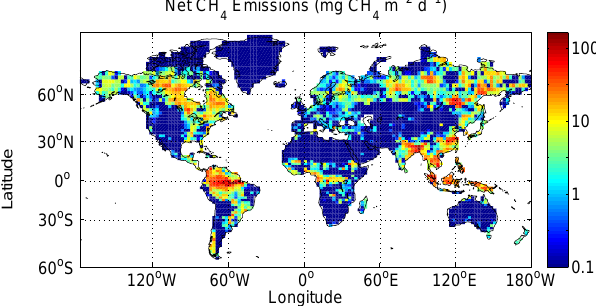
Fig. 6. Annual-average CH 4 emissions over the 25-yr simulation. The fluxes are shown on a logarithmic color scale, and truncated to be above 0.1mgCH 4 m − 2 d − 1 , to illustrate the large spatial hetero- geneity in simulated fluxes.